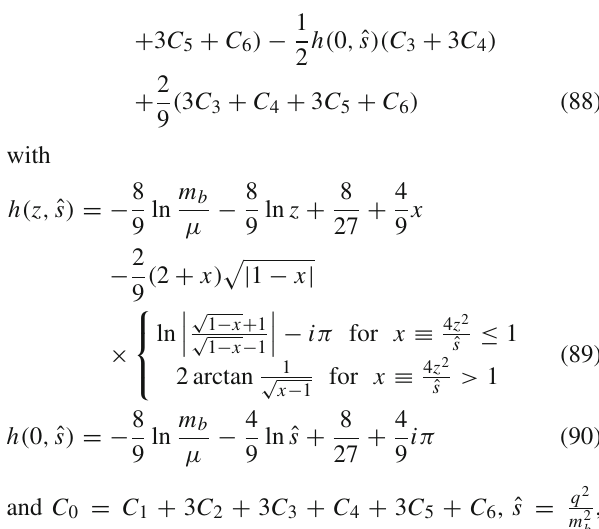
c.f., Eq. (77). Besides, we choose the CKM matrix ele- ments | V tb | = 1 . 019 ± 0 . 025, | V ts | = ( 39 . 4 ± 2 . 3 ) × 10 − 3 , | = ( 8 . 1 ± 0 . 5 ) × 10 − 3 and the fine-structure constant | V td = 1 / 137 [1]. The FBAs of lepton as functions of q 2 for α em − ( 1320 ) l − l + ( l = e , μ, τ) are shown in the decays B − → a 2 Fig. 6. For other FCNC induced semileptonic decays, the behav- iors of FBAs are similar. As can be seen from Fig. 6, the zero-crossing points of FBAs are the same for l = e , μ and do not exist for l = τ , which are different from the case of charged current induced semileptonic decays (c.f., Fig. 5). The numerical results of branching ratios, longi- tudinal polarization fractions and zero-crossing points of FBAs for all B ( s ) → Tl − l + ( l = e , μ, τ) decay modes are collected in Table 7, where the corresponding values for ¯ ¯ ¯ K ∗ 0 l − l + ( l = μ, τ) and B s → f (cid:3) l − l + ( l = μ, τ) B 0 → 2 2 decays calculated by pQCD [25] are also listed for compar- ison. We can see that our results as a whole are compat- ible with the corresponding pQCD values for these decay modes. The branching ratios decrease significantly with the mass of charged lepton. For the decay modes with ee or μμ in the final states, the branching ratios are at the order of O ( 10 − 8 − 10 − 7 ) , while those for the decays with ττ are smaller by three orders of magnitude. As in the case of charged current induced semileptonic decays, the first and second uncertainties of branching ratios comes from the form factors and CKM matrix elements, respectively. The uncer- tainties from these two sources are at the same order of mag- nitude and roughly (15–25)%. The decay modes with μμ in the final states have maximum longitudinal polarization frac- tions, which are approximately 70%. In contrast, the